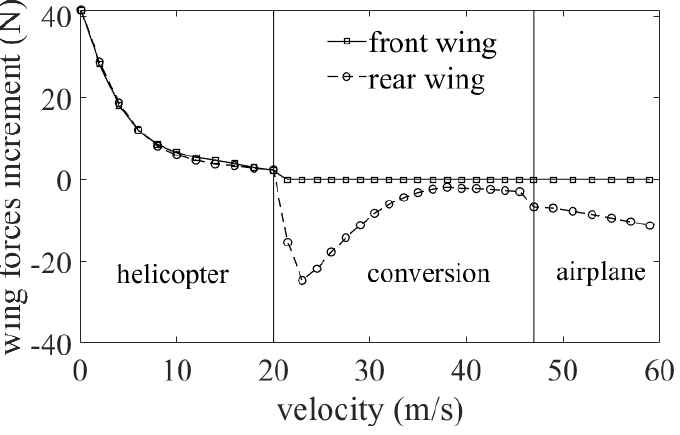
Figure 15. Vertical forces increment of front and rear wings caused by rotor – wing interaction.